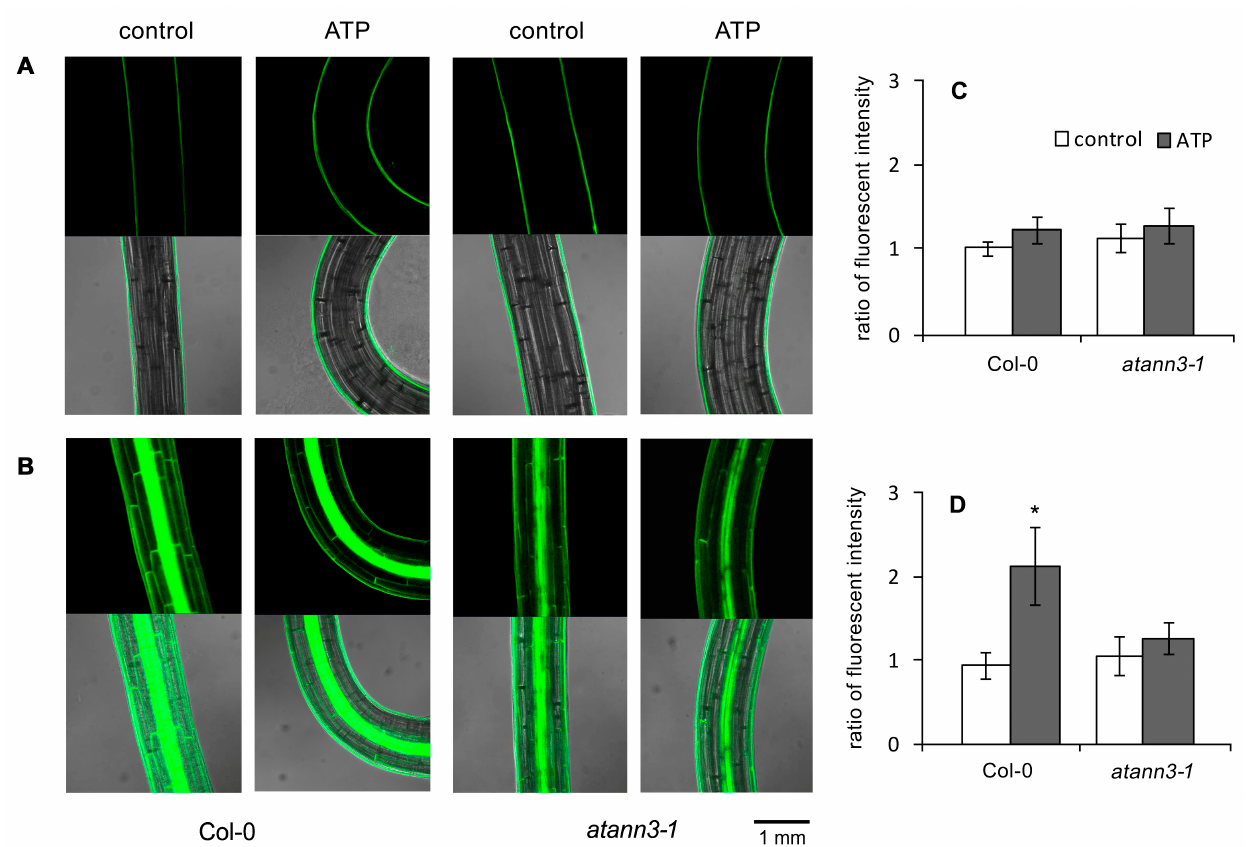
Figure 5. AtANN3 is involved in the eATP-induced PIN3-GFP distribution in hypocotyl cells. The 4-day-old seedlings of PIN2-GFP or PIN3-GFP transgenic lines were transplanted onto the medium containing 0.5 mM ATP and cultured for 2 more days. ( A , B ) Fluorescence in the hypocotyl of PIN2- GFP ( A ) and PIN3-GFP ( B ) transformant seedlings. The scale bar is shown in the lower-right corner of the image. ( C , D ) The fluorescence intensity ratio in cells at the inner side/outer side at the hypocotyl curve of PIN2-GFP ( C ) and PIN3-GFP ( D ) transformant seedlings. In each experiment, at least 15 samples were measured, and data from at least three replicates were combined to obtain mean ± SD based on Student’s t -test p -values (* p < 0.05).